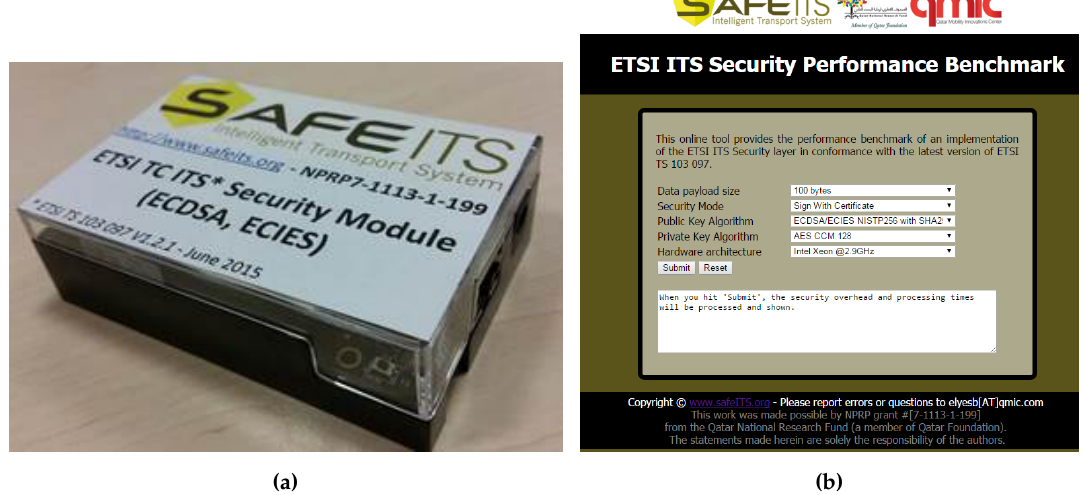
Figure 9. ETSI TC ITS Security Standard Compliant Experimental Test-Bed and Online Tool. ( a ) ETSI TC ITS Compliant Security Module (BeagleBone version); ( b ) Online tool for ITS Security Performance Benchmark [18].